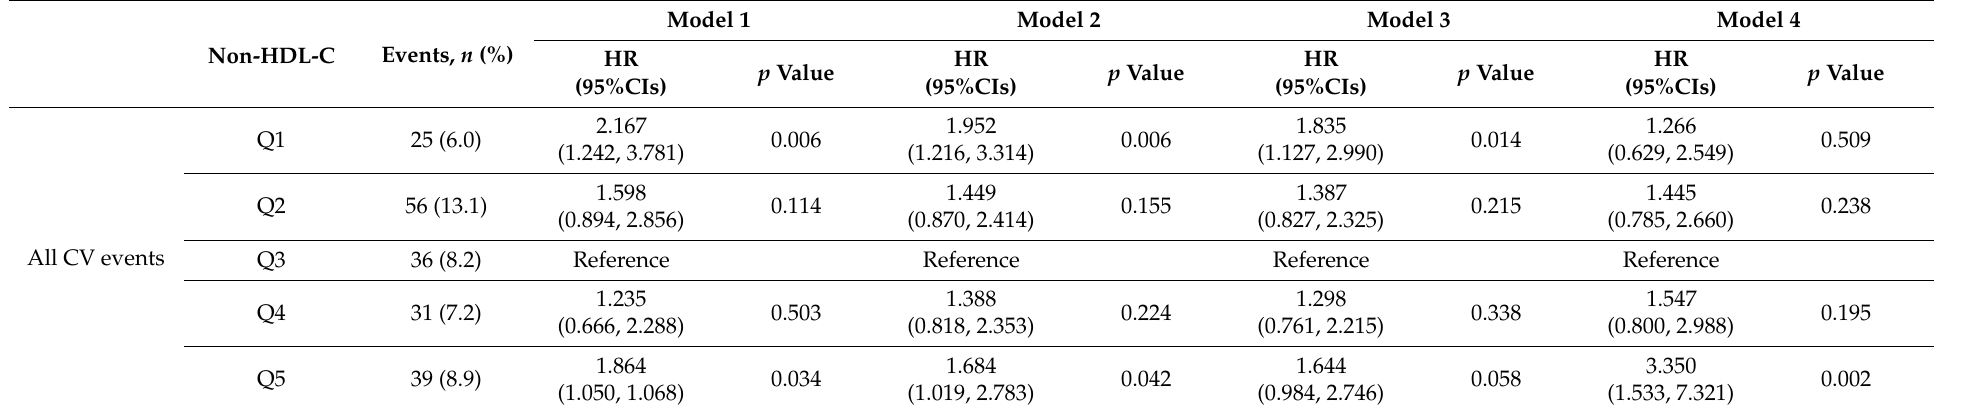
Table 3. HRs for the secondary outcomes by non-HDL-C